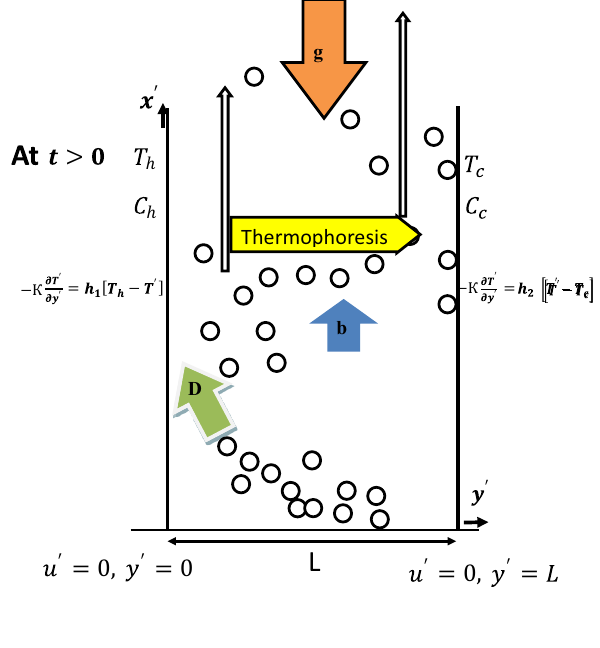
Fig. 1 Physical description of